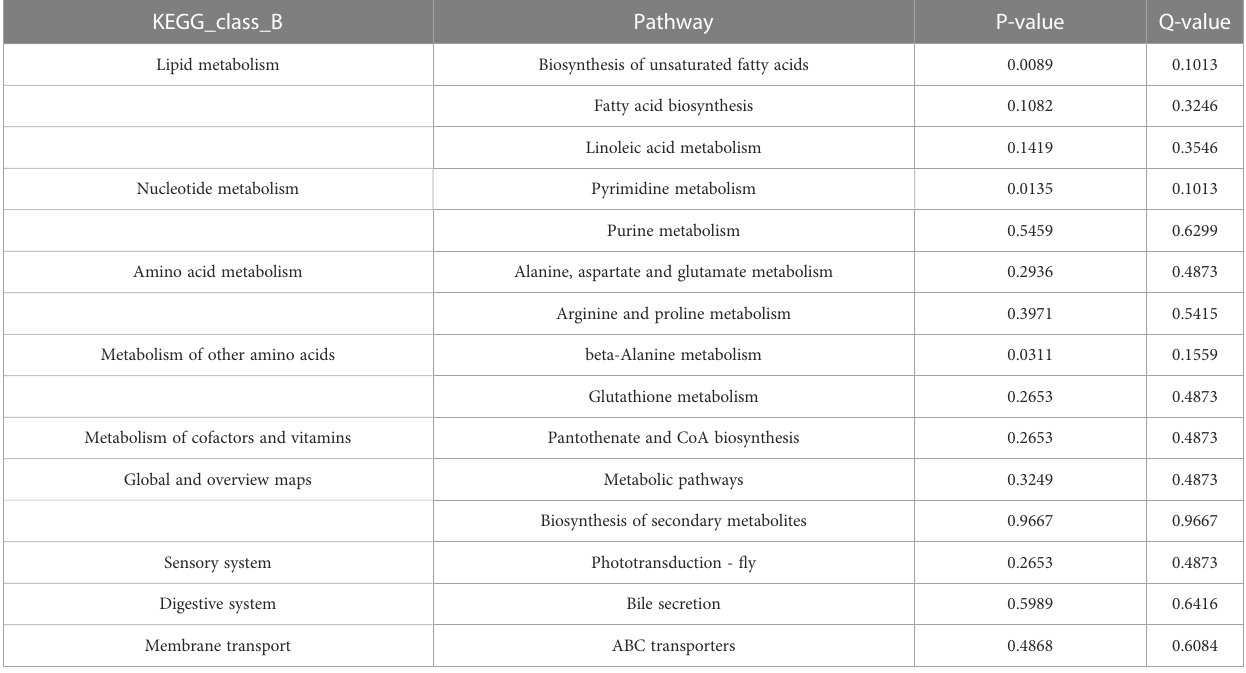
TABLE 2 Top 15 differential pathways of juvenile Trachinotus ovatus under low-temperature